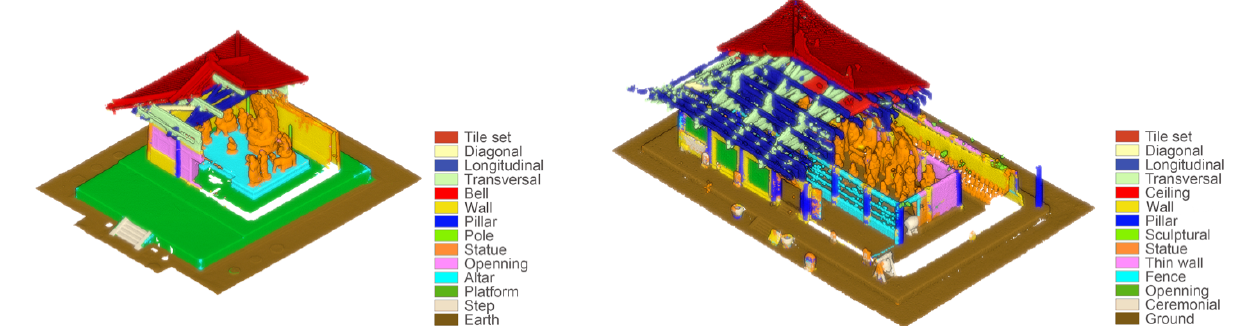
Figure 12. RF non-hierarchical classification results for the NCS (left) and FKS (right).